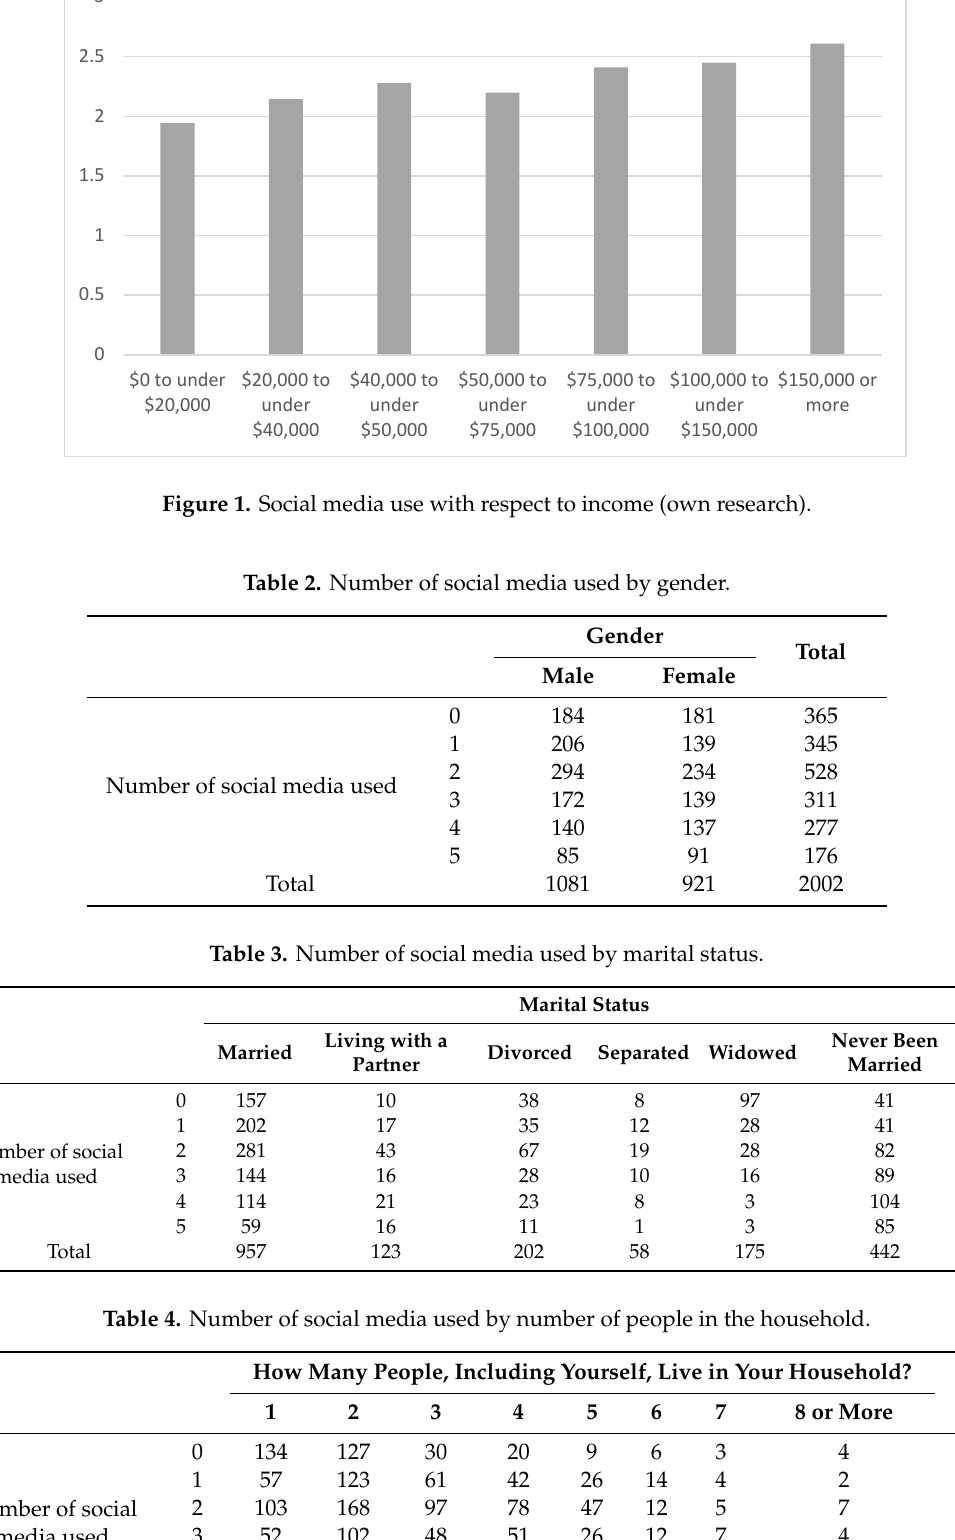
Table 4. Number of social media used by number of people in the household.